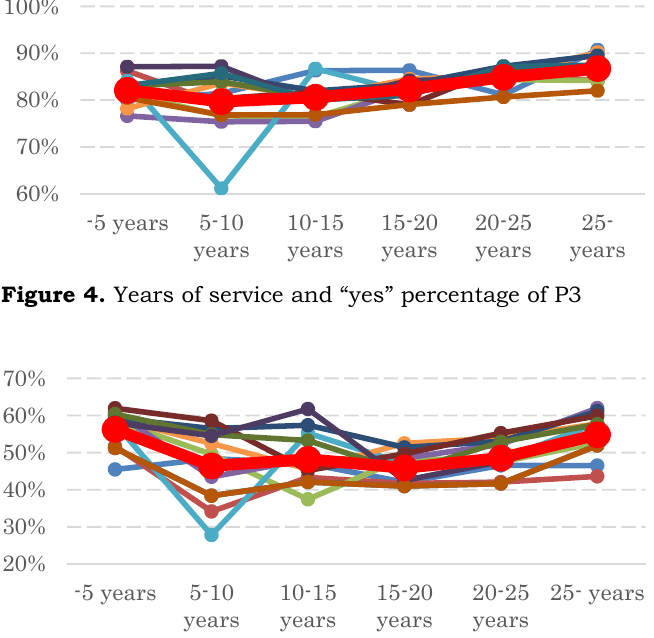
Figure 5. Years of service and “no” percentage of